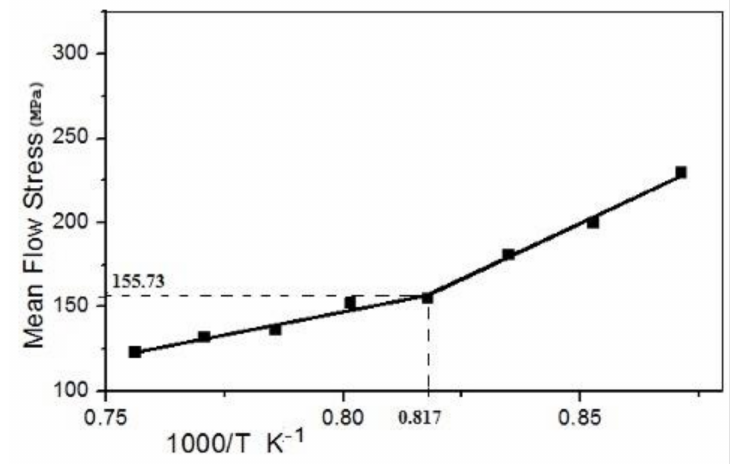
Figure 3. Mean flow stress curve with inverse absolute temperature K − 1